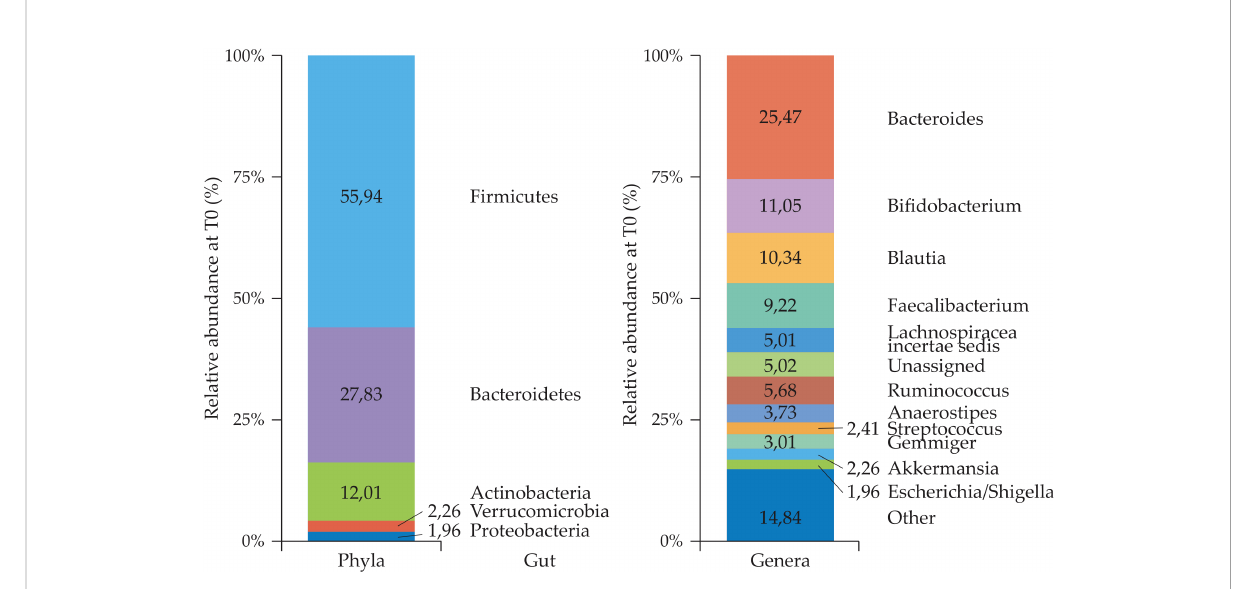
FIGURE 2 Gut microbiota pro fi les (phyla and genera) in the total population ( n = 144) at